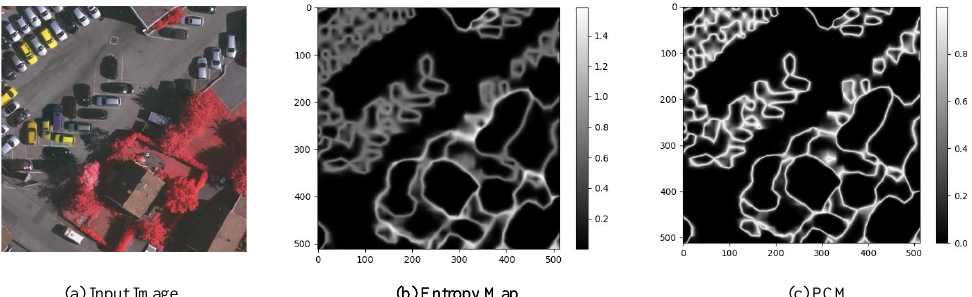
Figure 4. Visualization of the two gating mechanisms. ( a ) The input image of size 512 × 512. ( b ) The entropy map of the auxiliary prediction result of the last block of ResNet. The rightmost vertical axis represents the different entropy values in the image. The higher the brightness, the higher the entropy. ( c ) The PCM of the auxiliary prediction result of the last block of ResNet. The higher the brightness, the higher the prediction confusion.